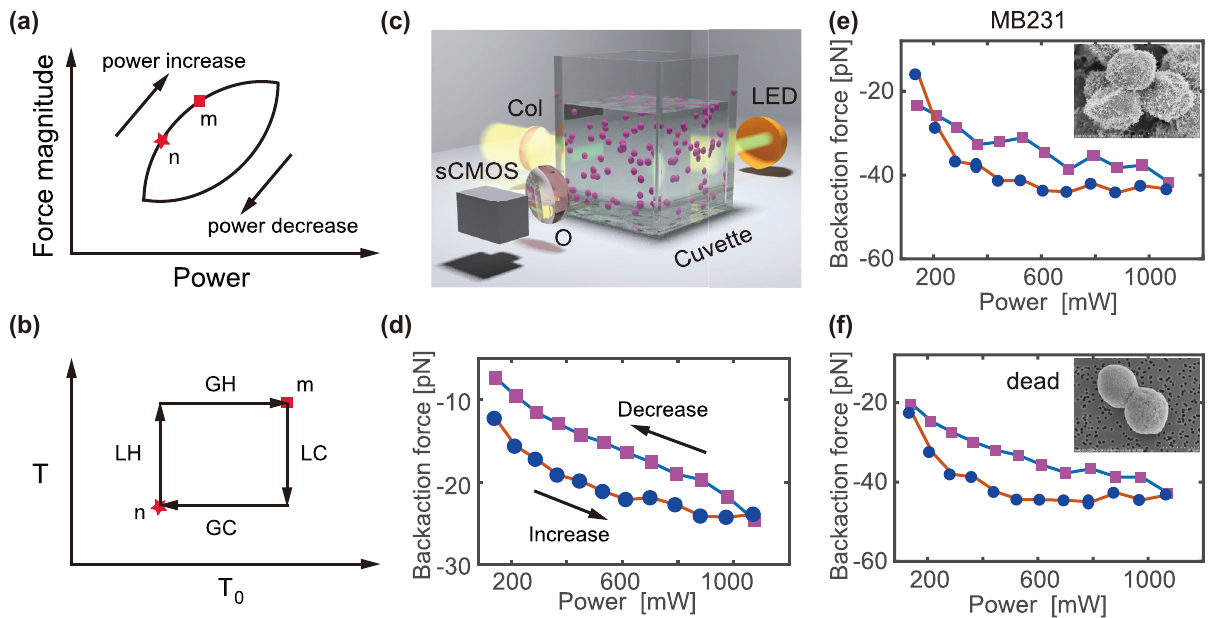
Figure 2: Force hysteresis on cancer cells. (a) Demonstration of backaction force hysteresis with respect to laser power. Markers show two representative states on the loading curve. (b) The back-action force was determined by four heating stages. LH, local heating; LC, local represents the ensemble temperature, and T denotes the temperature inside the nanojet. cooling; GH, global heating; GC, global cooling. T 0 (c) Schematic of the experimental setup for the backaction force experiment. CMOS, complementary metal oxide semiconductor; LED, light-emitting diode; Col, collimator; O, objective. (d) The force hysteresis on the polystyrene microparticle with diameter of 5 μ m. (e–f) The hysteresis for the cancer cells under different physiological conditions. The loading/unloading curve for (e) live and (f) fixed breast cancer cell (MDA-MB231). Insets show the SEM photos of MDA-MB231 cancer cells under (e) native and (f) ethanol immersion conditions. The magnitude of force is stronger in the power loading stage than in unloading stage with the same power when the hysteresis exists for both the standard polymer sphere and the cancer cell. Note that (a) shows the magnitude of force, while the ‘‘–’’ sign in (d–f) indicates the backward motion direction. Hence the force change direction is consistent between (a) and